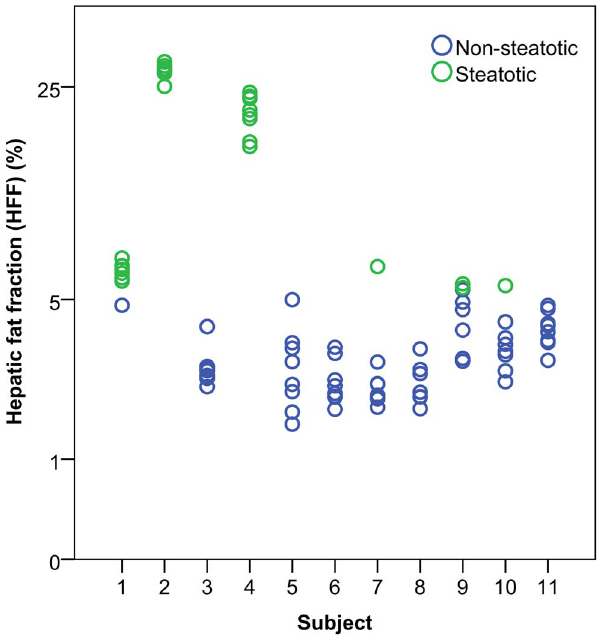
Figure 1. Distribution of HFF measurements in all subjects. For each subject (n=11), four circular regions-of-interest (ø22.3 mm) were drawn in each of the eight segmental regions (II – VIII) according to the Couinaud-Bismuth classification and averaged, resulting in a total of 88 measurement points. Five subjects demonstrated non-steatotic HFF ( # 5.5%) measurements only, two subjects had steatotic HFF ( . 5.5%) measurements only, and four subjects had both steatotic and non- steatotic